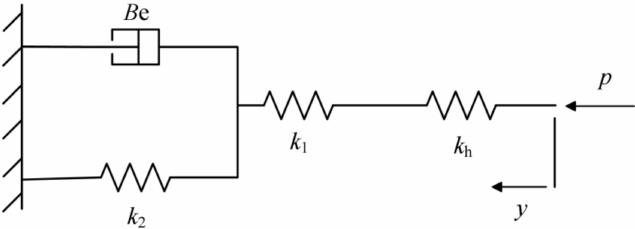
Figure 3. Viscoelastic model for